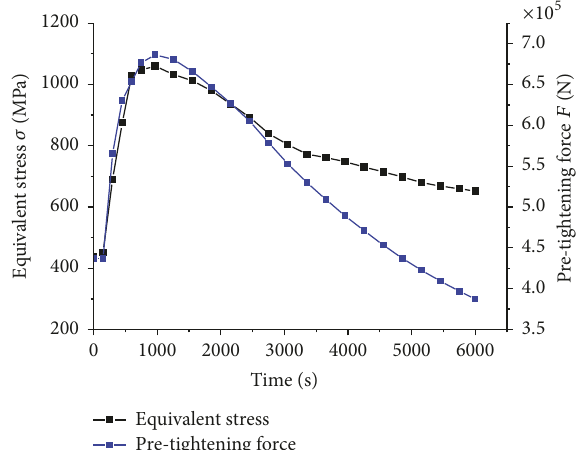
Figure 17: The variation of the maximum equivalent stress and pretightening force of the compressor tie rod during start-up period.